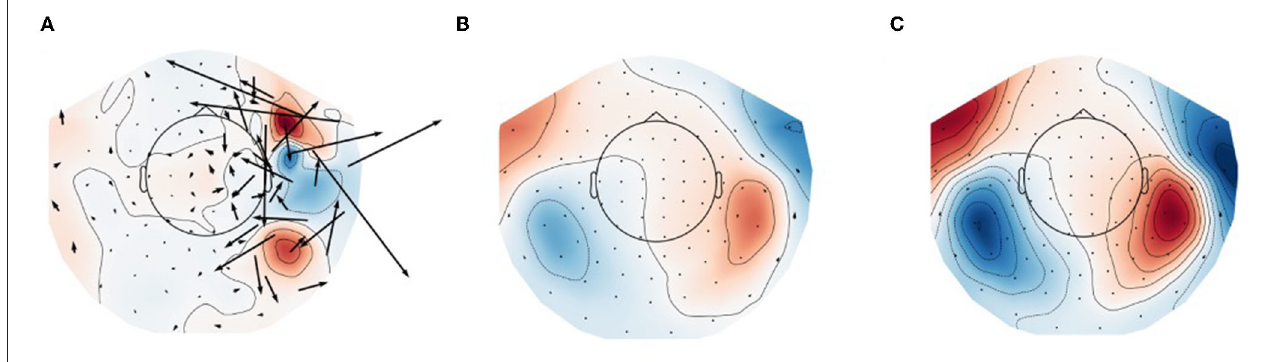
FIGURE 1 | Field topographies of bilateral evoked auditory responses (at 150ms) in a 6-month-old participant. (A) Raw data (no artifact suppression), (B) data processed with tSSS, and (C) data processed with tSSS + movement compensation. Black arrows represent estimation of equivalent current flow at the MEG sensor